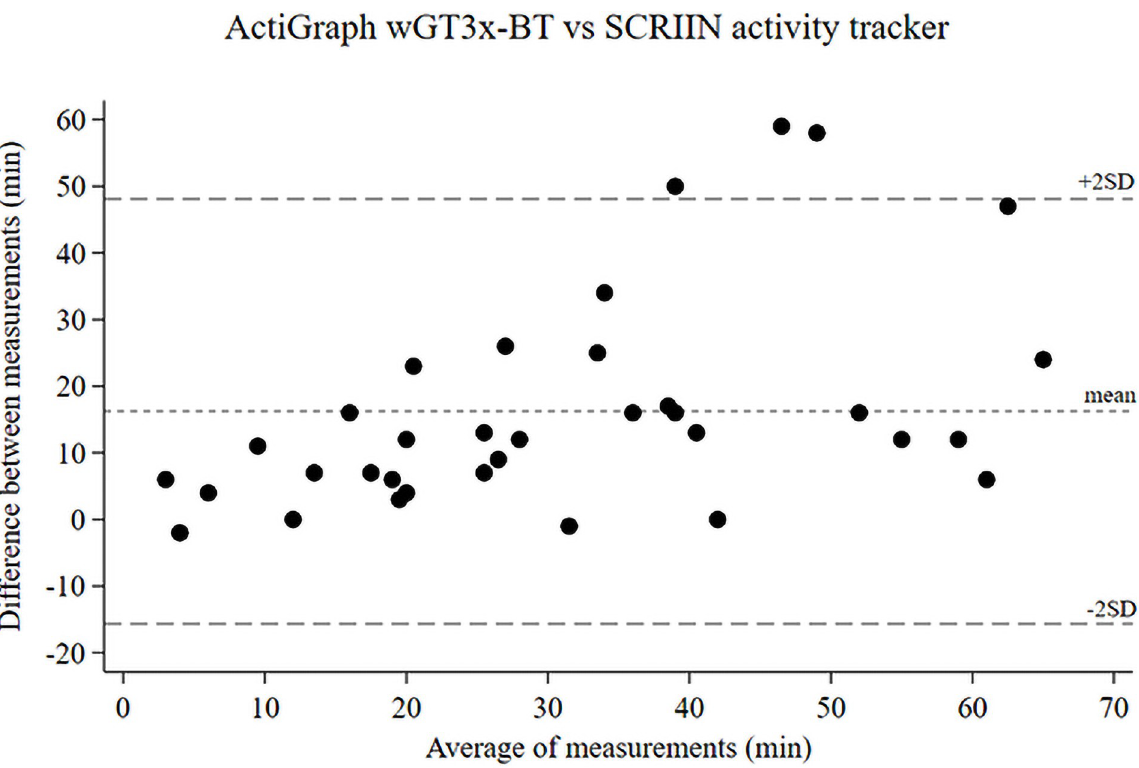
Fig 2. Bland-Altman plot. Comparing physical activity measured with ActiGraph wGT3x-BT in moderate-to-vigorous physical activity and the Swedish SCRIIN activity tracker in active minutes.